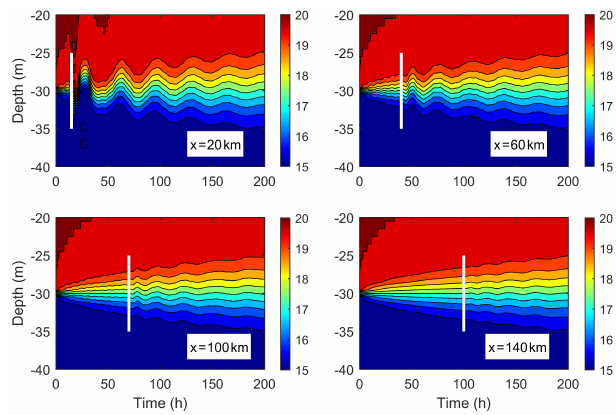
Figure 8. Time series of temperature at x = 20, 60, 100, and 140km. White lines denote the arrival of internal waves. The con- tour interval is 0.5 ◦ C.